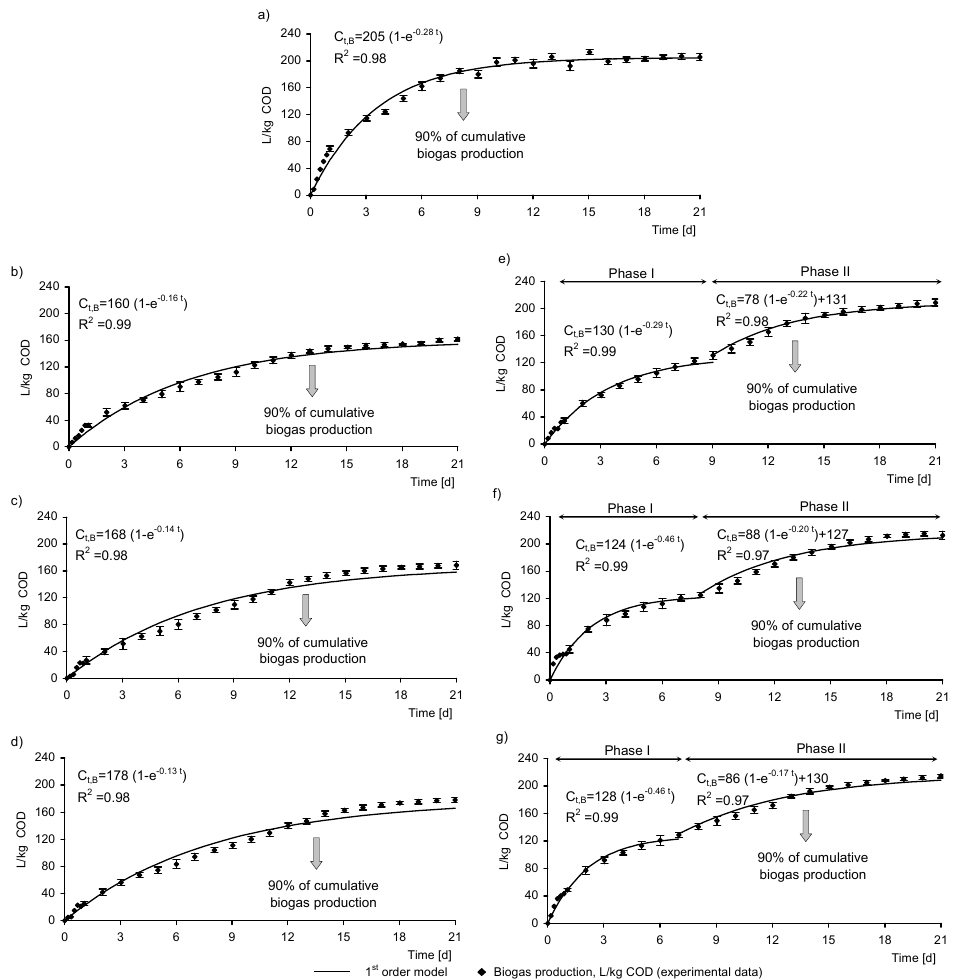
Figure 4. Biogas production from the SS and the retentates after UF and MF during GP21 test; ( a ) SS, ( b ) MF 0.2, ( c ) MF 0.3, ( d ) MF 0.4, ( e ) UF 0.2, ( f ) UF 0.3, ( g ) UF 0.4.